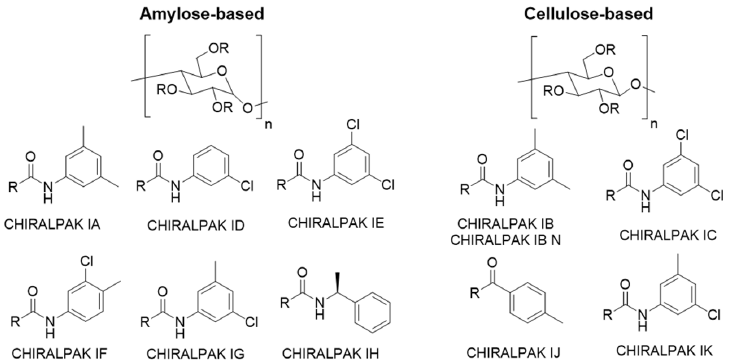
Figure 2. Structures of polysaccharide-based chiral selectors used for method development screening.